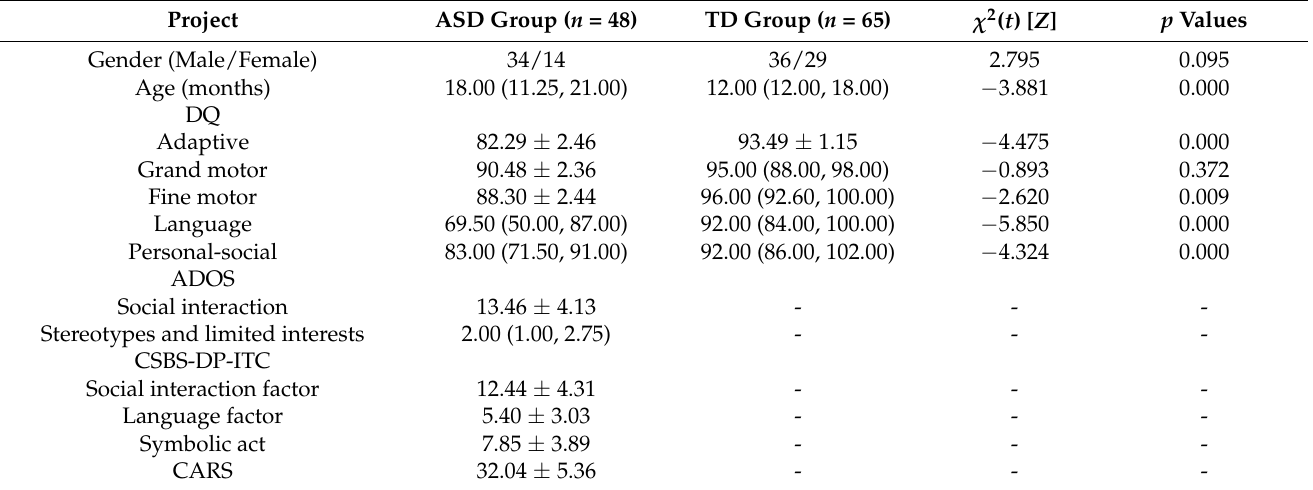
Table 2. Comparison of general data between the ASD and TD groups [ ⎯χ ± s or M ( P 25 , P 75 )].